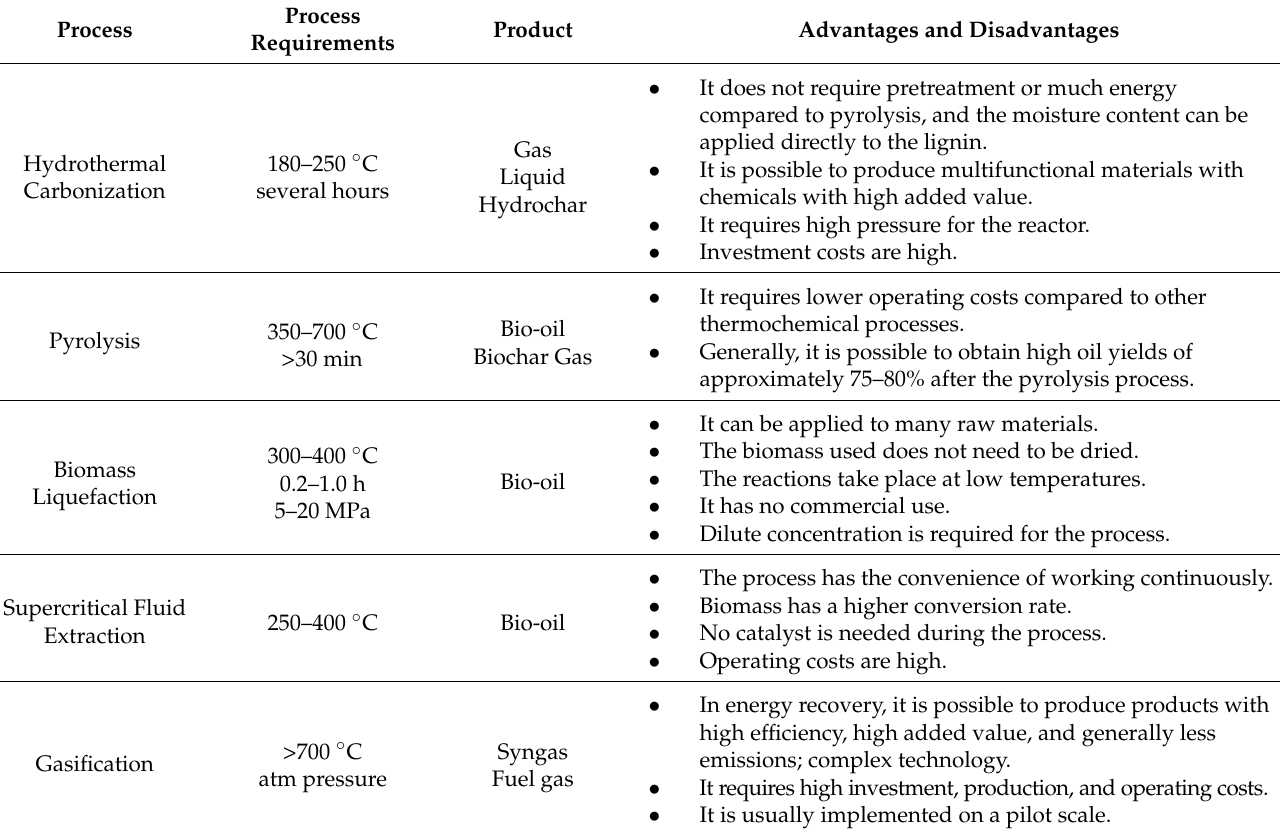
Table 1. Thermochemical pathways used to convert biomass to biofuel, process requirements, and post-process